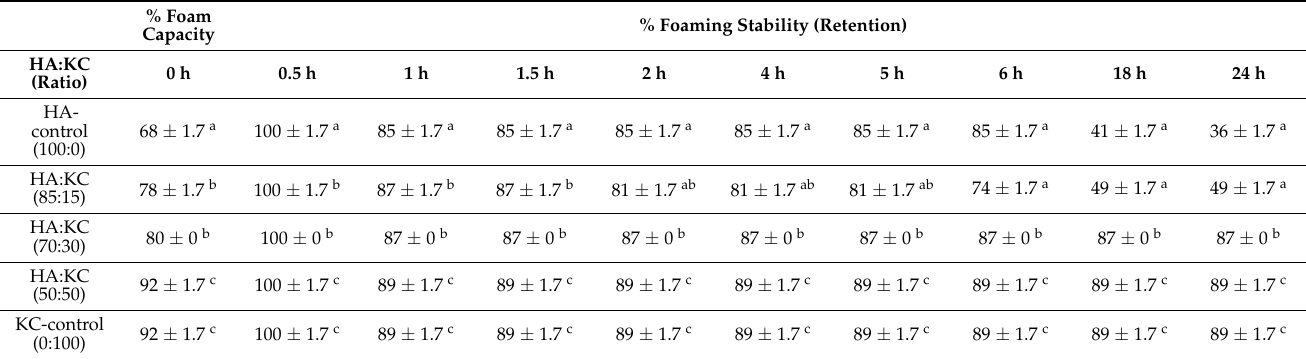
Table 5. Foaming capacity and stability of skim milk sample at 30 ◦ C treated with 0.1% HA + KC concentration and different ratios of HA + KC